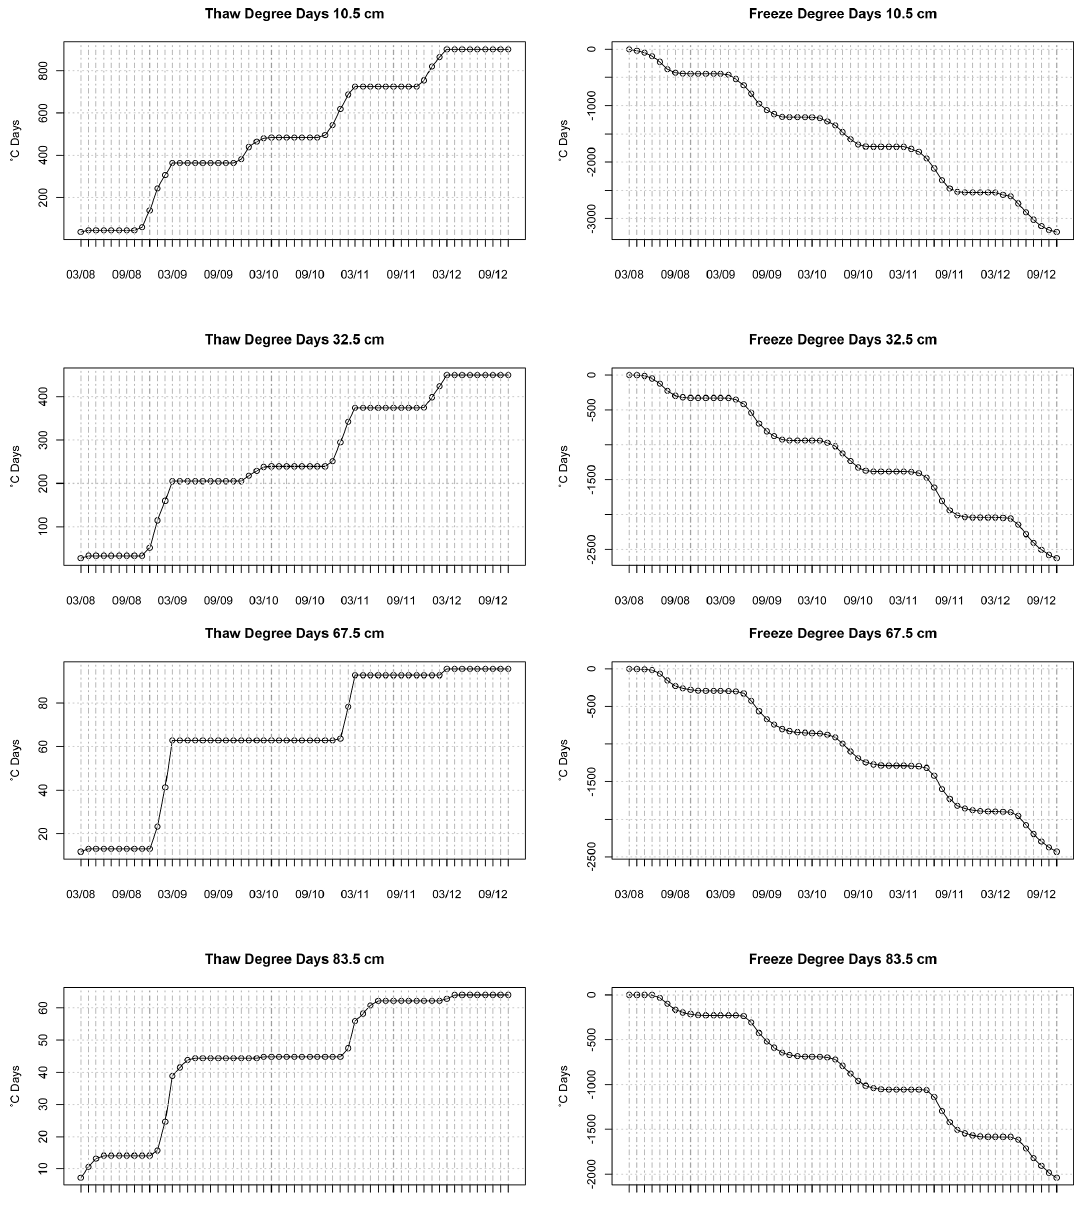
Figure 4. Thaw degree days and freeze degree days for F1, F2, F3 and F4.